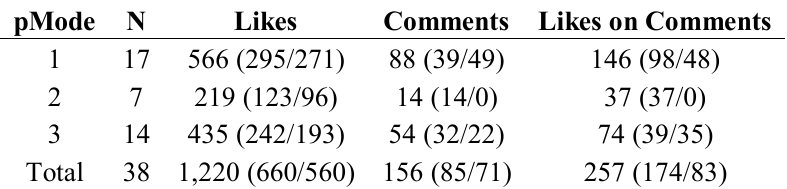
Table 2. Responses of messages by presentation mode.